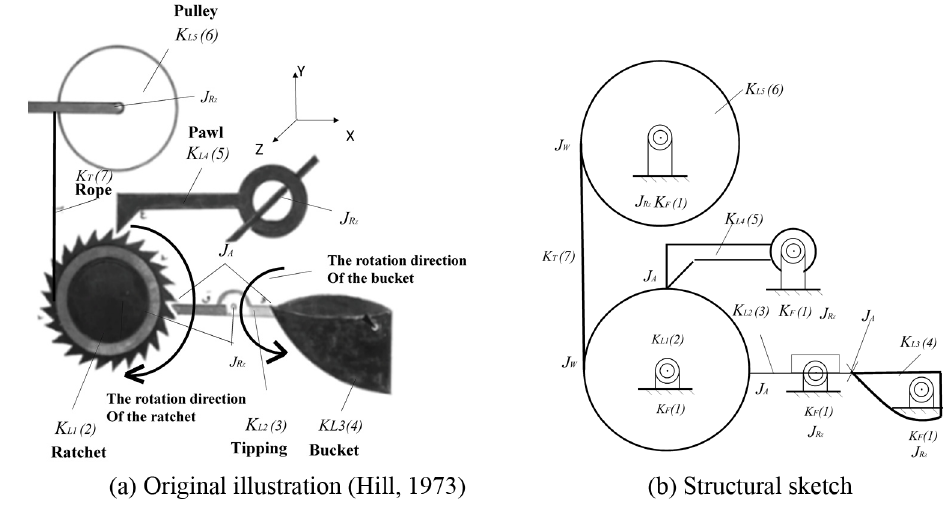
Figure 10. Al-Jazari’s peacock tipping bucket and ratchet mechanism.